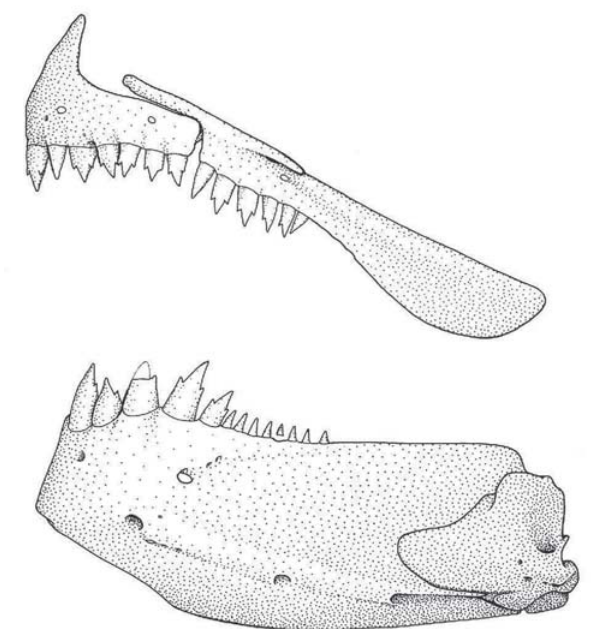
Fig. 59. Mimagoniates lateralis , adult male, USNM 236088, 31.6 mm SL; jaws and dentition, lateral view, right side, anterior at